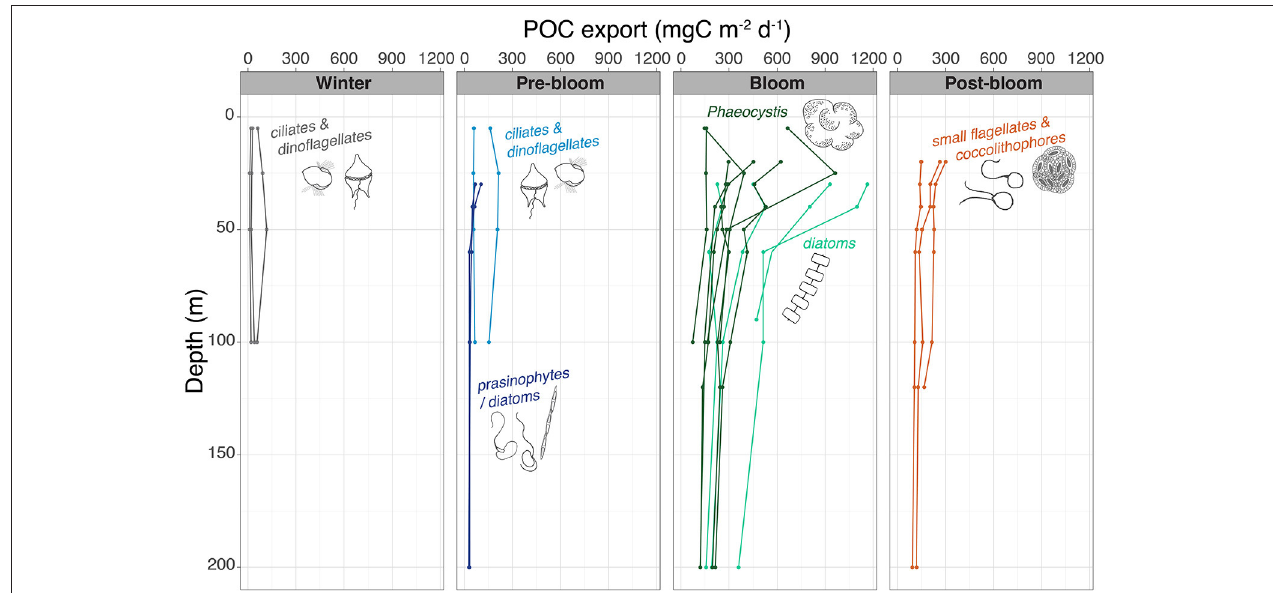
FIGURE 7 | Vertical export flux of POC with depth. The dominant groups of protists in the surface waters are shown alongside their respective profiles or stations.